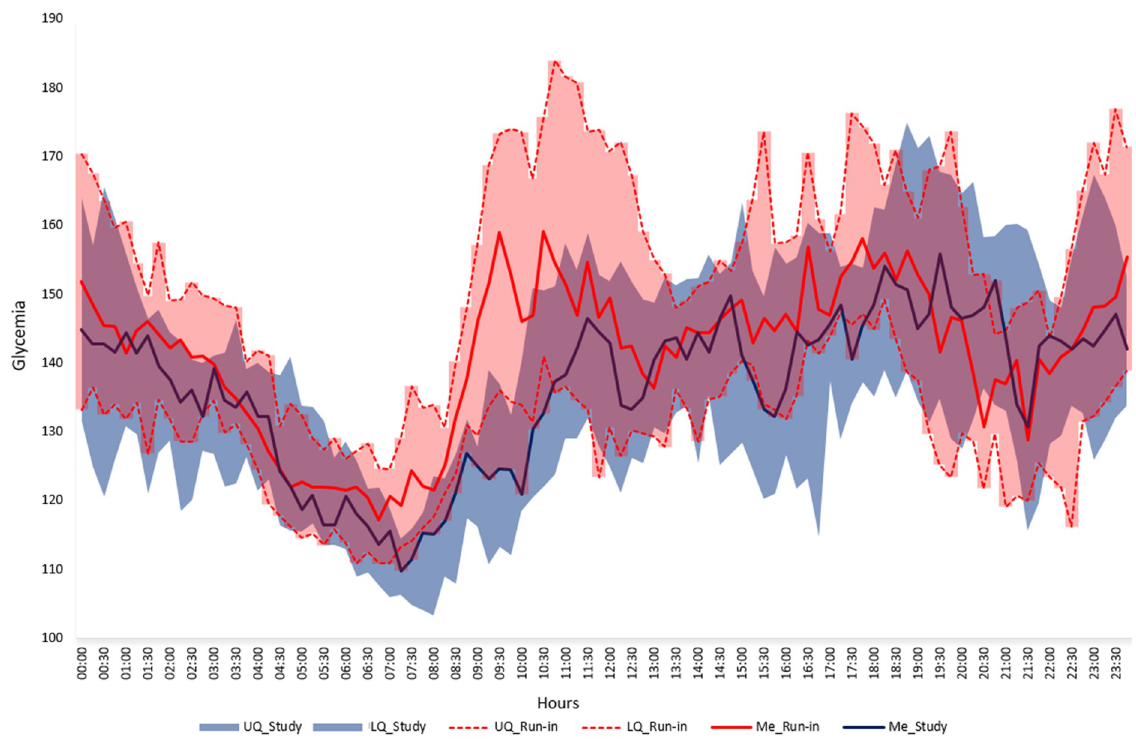
Fig 4. Median (IQR) glycemia in the last 4 weeks of the study period (blue area) and the run-in (pink area). UQ—upper quartile, LQ— lower quartile, Me—median.